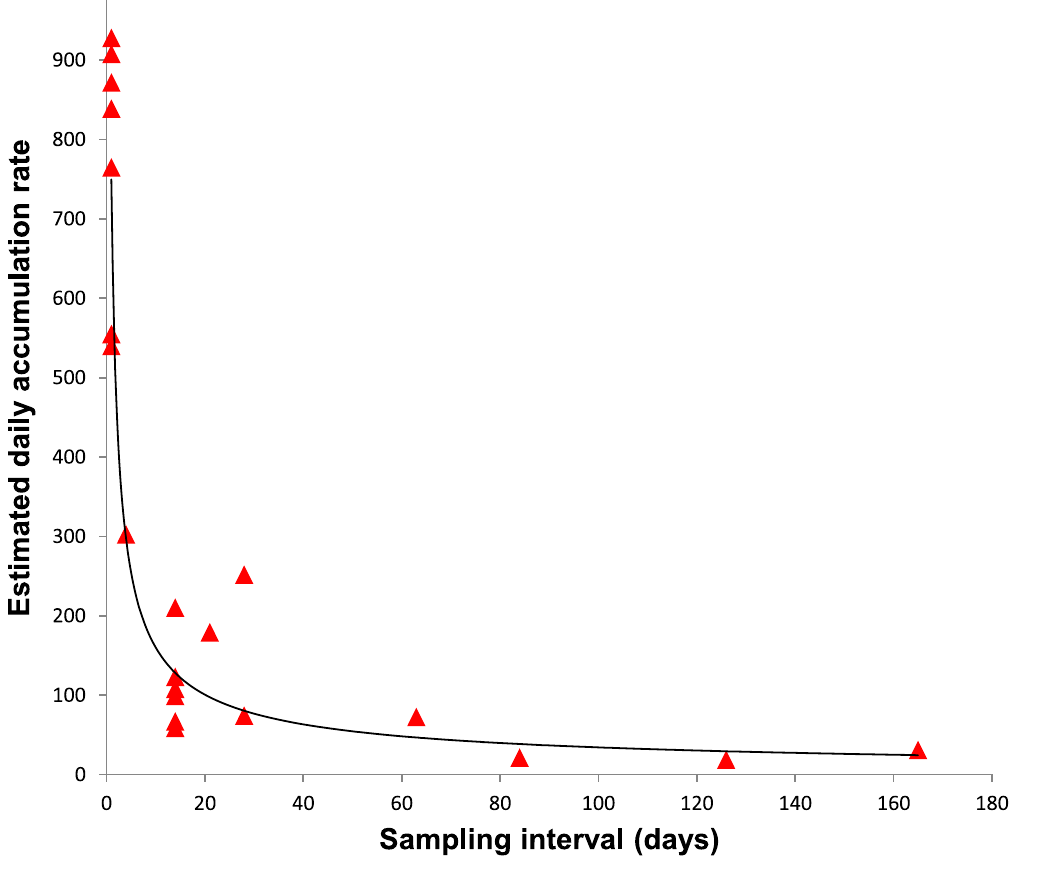
Figure 2. Plot of estimated daily accumulation rate of marine debris against interval between sample periods (days) for Charlesworth Bay. The regression is a power function with an r 2 of 0.872 and the following equation: estimated daily accumulation (y) =749.81 interval(x) 2 0.67